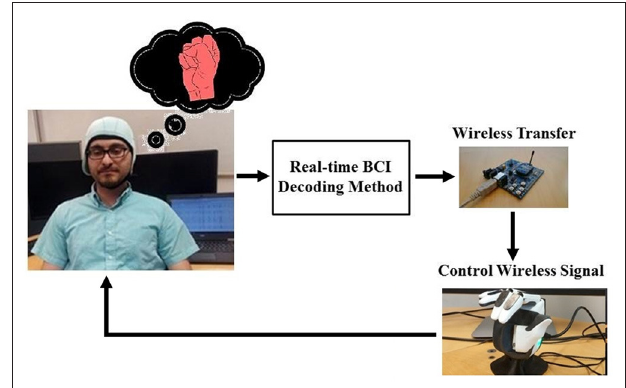
FIGURE 1 | The experimental procedure and the experimental setup for controlling a bionic hand.